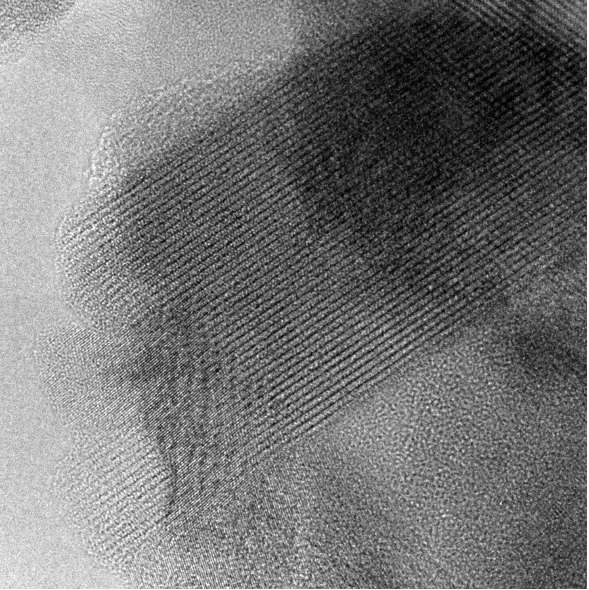
Figure 8. HR-TEM image of a sample with x = 0.5 nanocrystallized at 480 °C. The visible area is 50 nm × 50